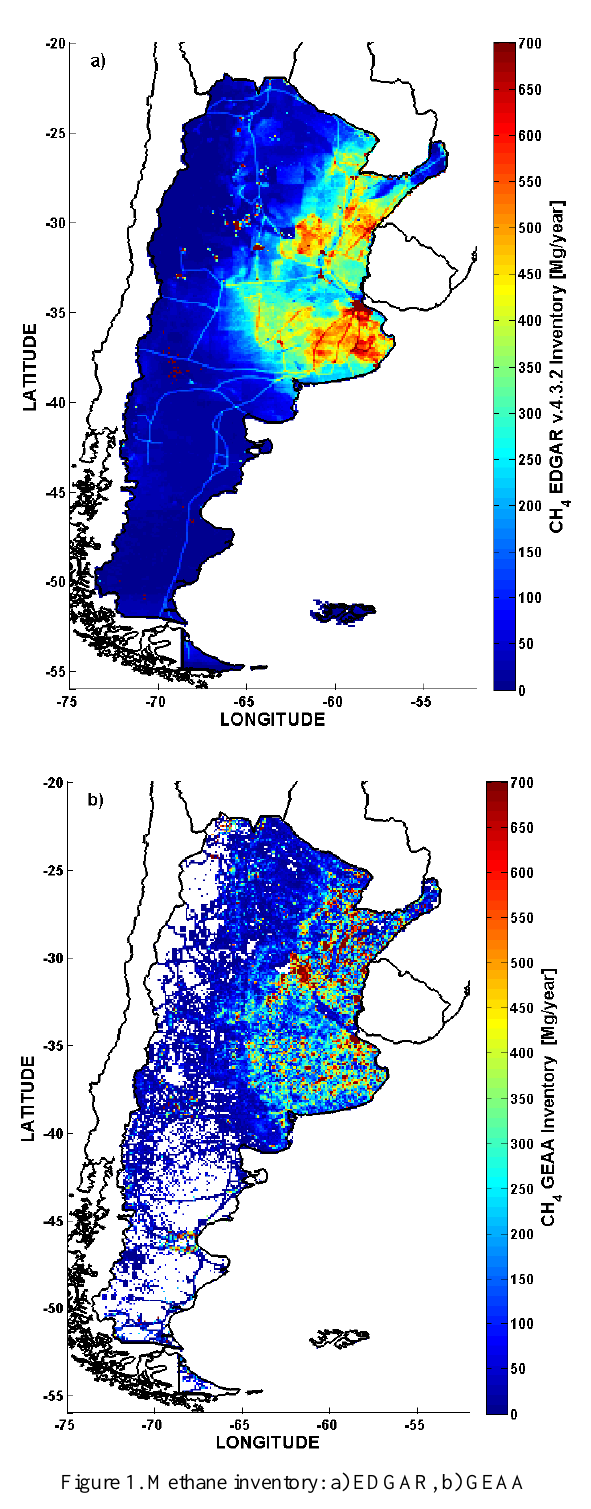
Figure 1. Methane inventory: a) EDGAR, b) GEAA